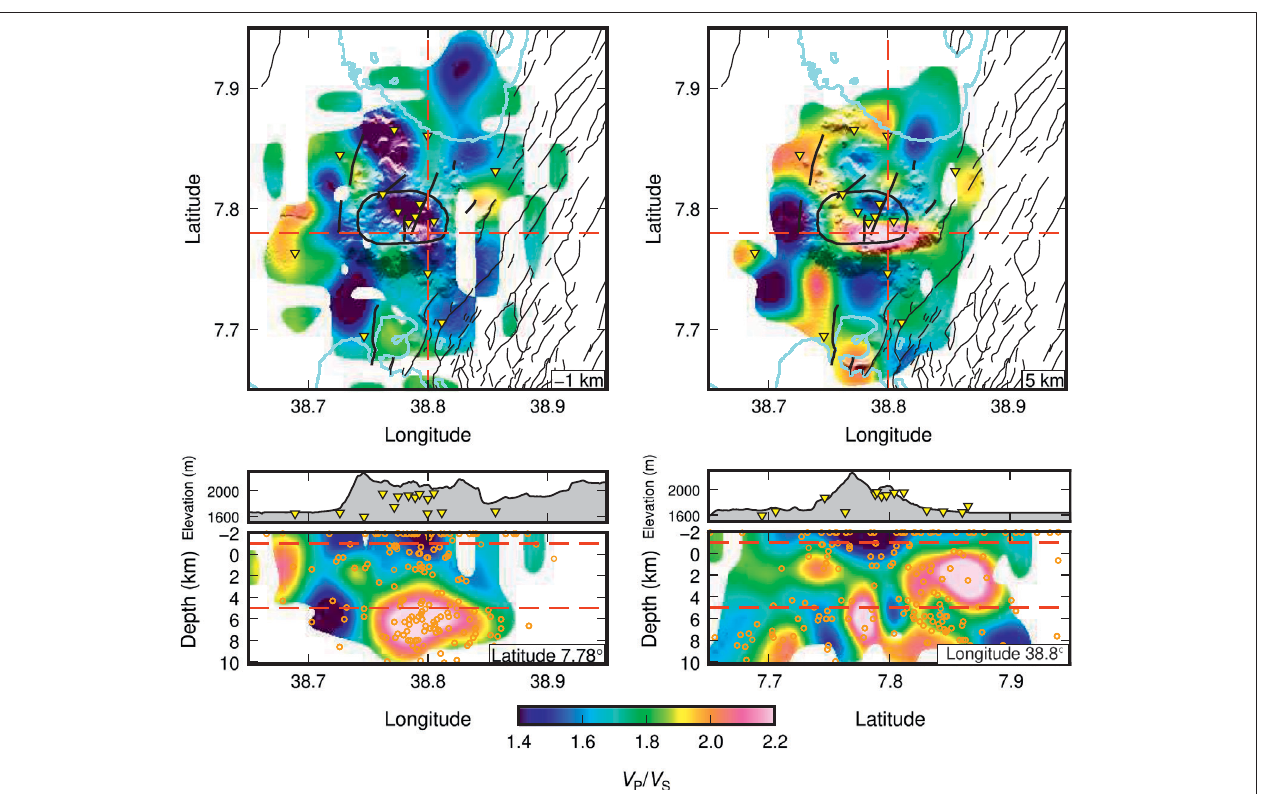
FIGURE 6 | Depth slices (at 1 km above sea level and 5 km below sea level) and east – west and north – south cross-sections through the tomographic solution model of the V P / V S structure (shown as an absolute value). The model is only plotted in regions where there is resolution based on Fréchet derivatives (see SupplementaryMaterial ).Yellowtrianglesindicatestationlocations,blacklinesonthedepthslicesindicatemappedfaultlocationsandsmallopencirclesonthecross- sections indicate event locations. Topography is shown above the cross-sections and indicated by hillside shading on the depth slices. See Supplementary Material for the V P and V S models.